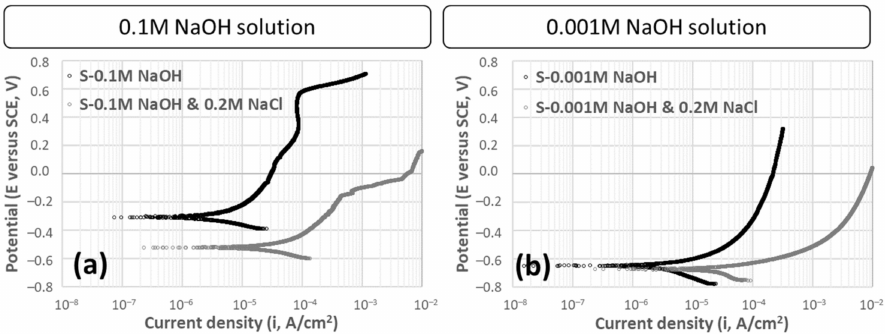
Figure 9. Anodic polarization curves of sand blasted steel (S) in ( a ) 0.1 M NaOH and ( b ) 0.001 M NaOH aqueous solutions without and with the addition of 0.2 M